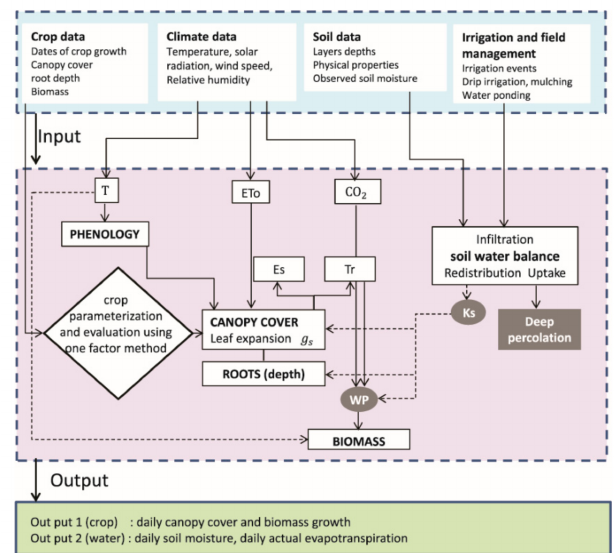
Figure 3. Flow chart of parameterisation of AquaCrop in this study (adjusted from [76]). T is temperature, ETo is potential evapotranspiration, gs is stomatal conductance, WP is water productivity coefficient, Ks is stress coefficient, Es is soil temperature, Tr is crop